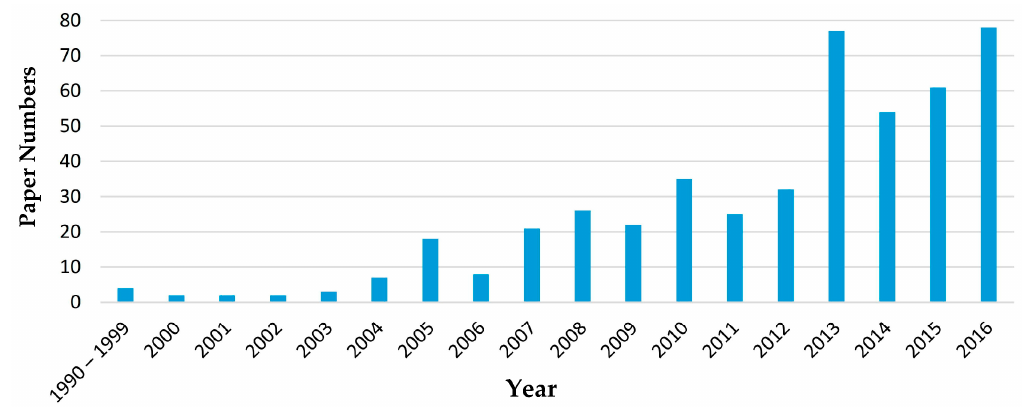
Figure 1. Number of published papers that, according to Scopus, include the terms cement and nanotechnology or nanomaterials in the title, abstract or keywords, limited to the fields of engineering and materials science.